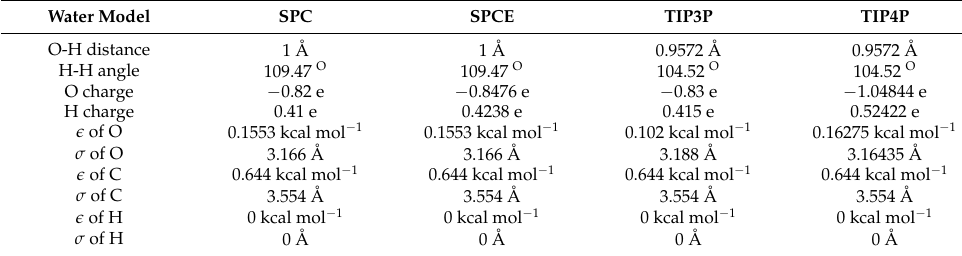
Table 1. Parameters of atoms used in each simulation. Water